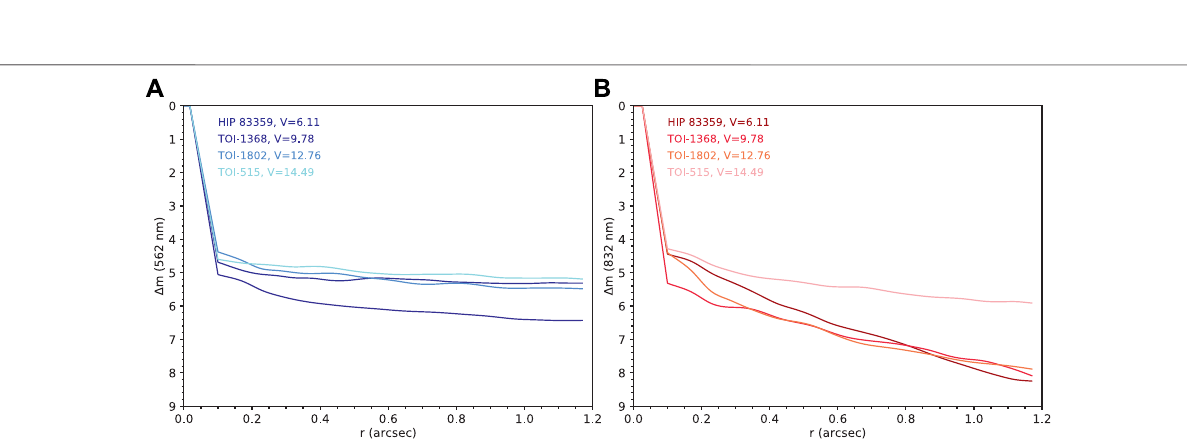
rather than its statistically proper log-normal distribution.